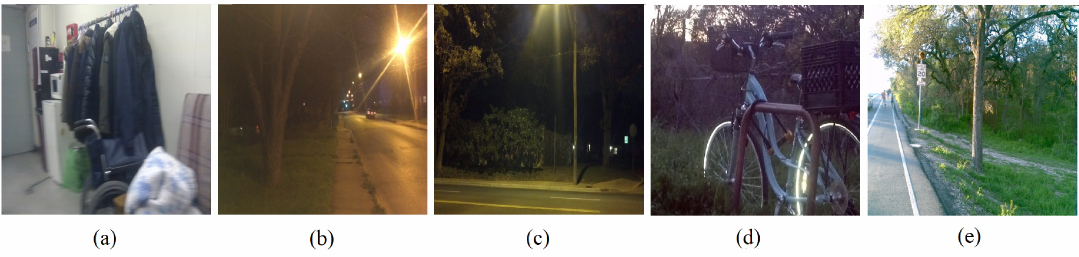
Figure 4. The five distorted images in the WIQCD database [30]: ( a ) MOS = 25.33; ( b ) MOS = 35.89; ( c ) MOS = 48.94; ( d ) MOS = 54.58; and ( e ) MOS =